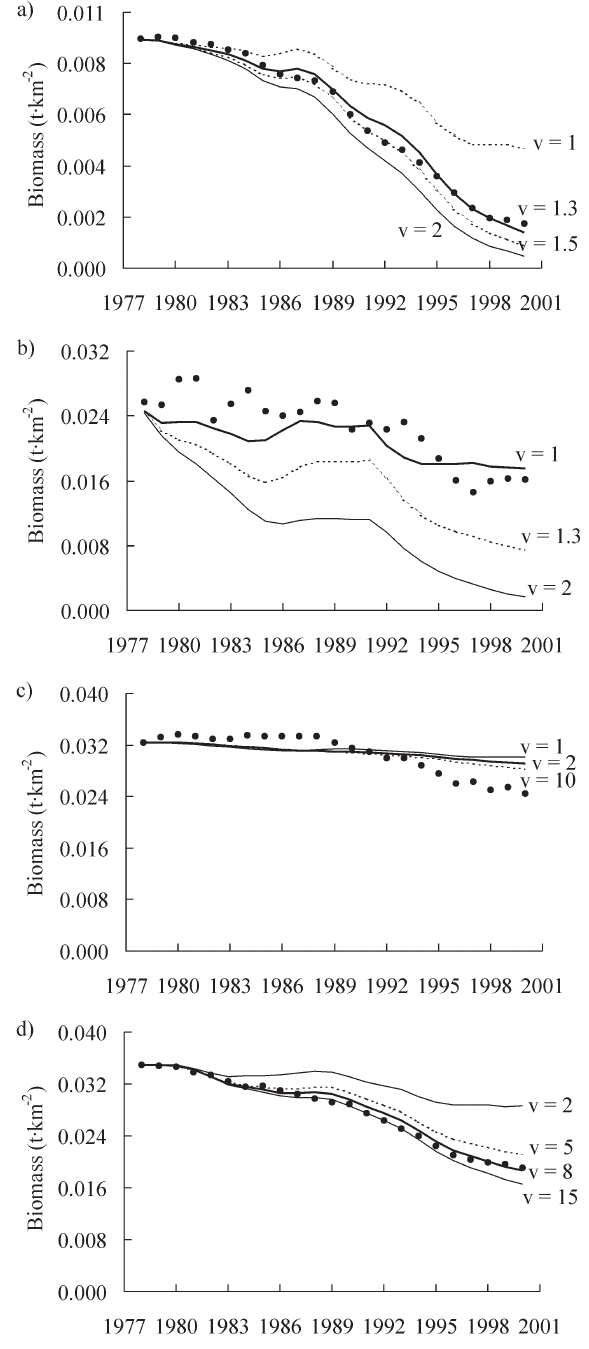
Fig . 4. – Verification of the model: observed time series of biomass (dots) and estimated values (lines) from Ecopath with Ecosim un- der different settings of vulnerability (v) for swordfish (a), other large pelagics (b), sharks (c), and tunas (d) off northeastern Brazil in